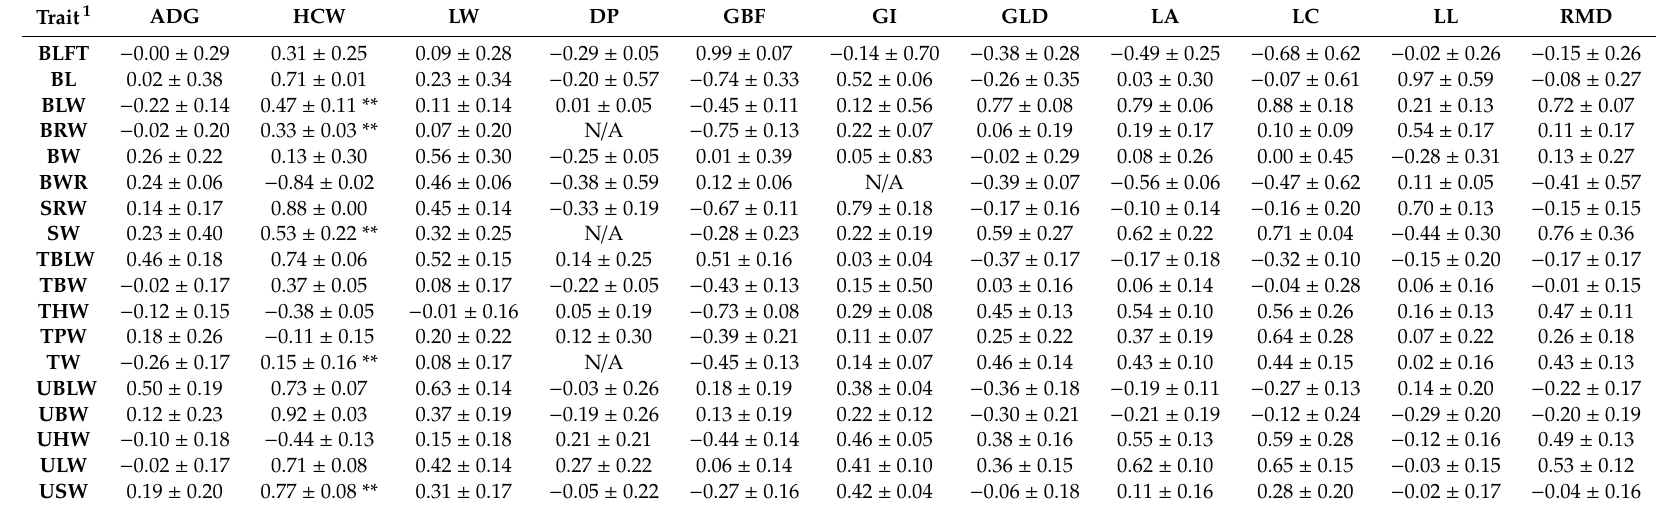
Table 10. Genetic correlations between conventionally measured carcass traits and novel carcass